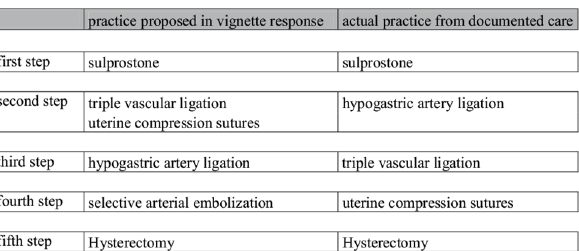
Fig 4. Example of final agreement and sequential agreement. In this example final agreement was high because the final treatment proposed at the last step of the vignette response was identical to the final treatment administered at the end of the vignette source situation in the documentation: hysterectomy. However sequential agreement was low because the management sequence was dissimilar between that proposed in the vignette response and that in the vignette source situation from the documentation: selective arterial embolization was added as a potential vignette response.